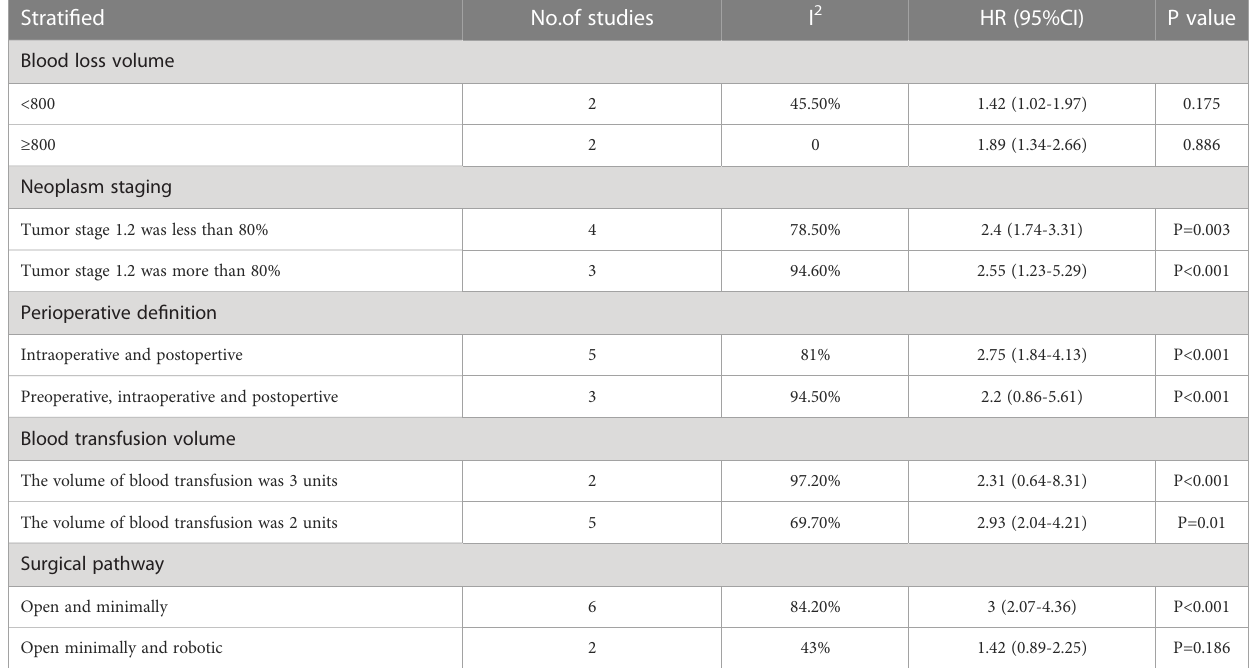
TABLE 4 Subgroup analysis of recurrence-free survival. Strati fi